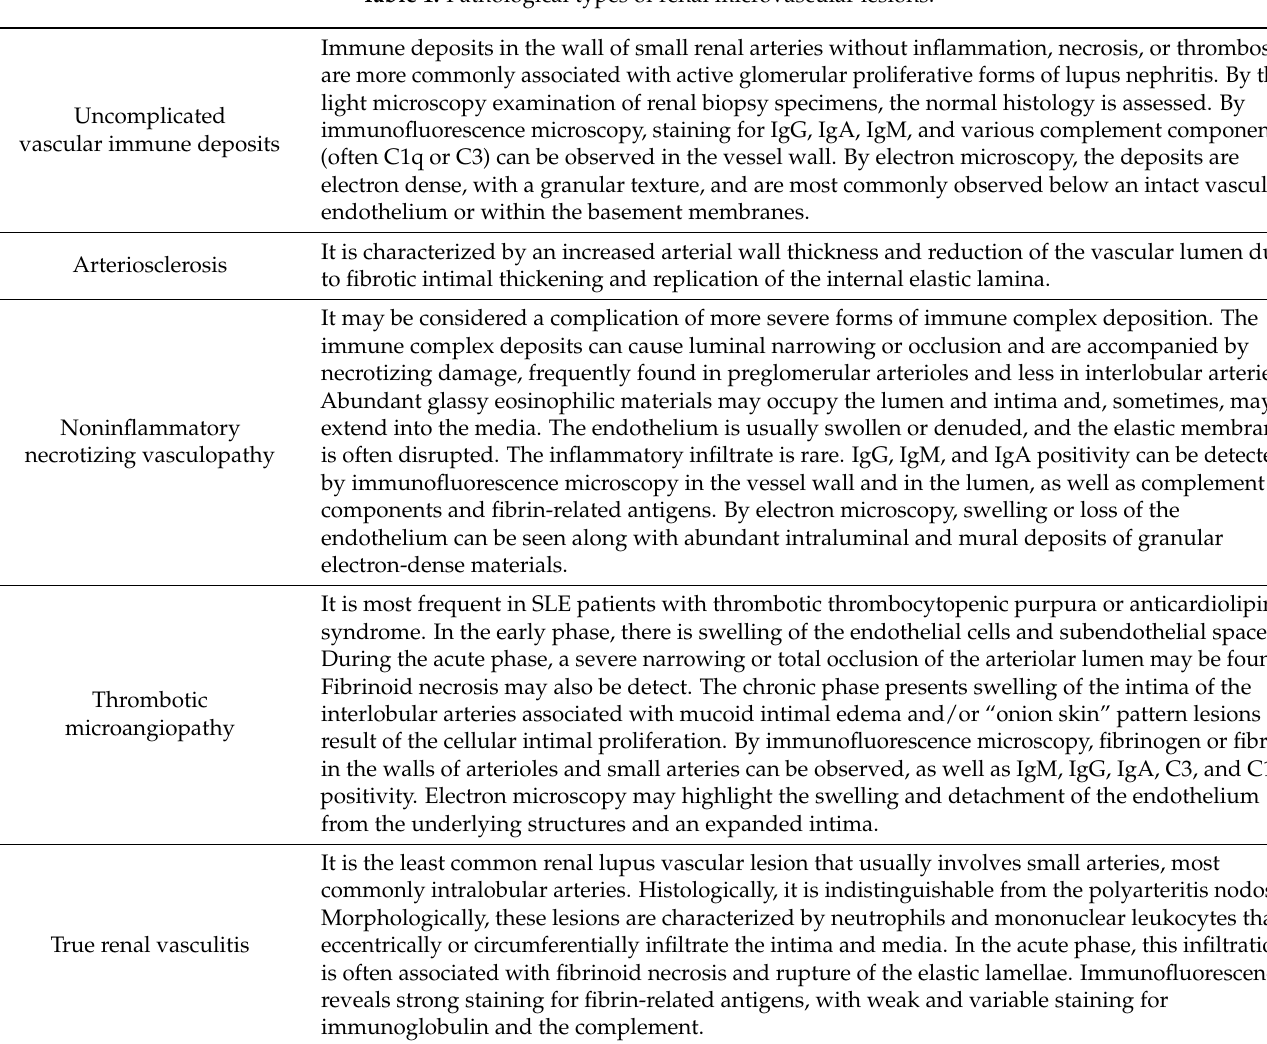
Table 1. Pathological types of renal microvascular